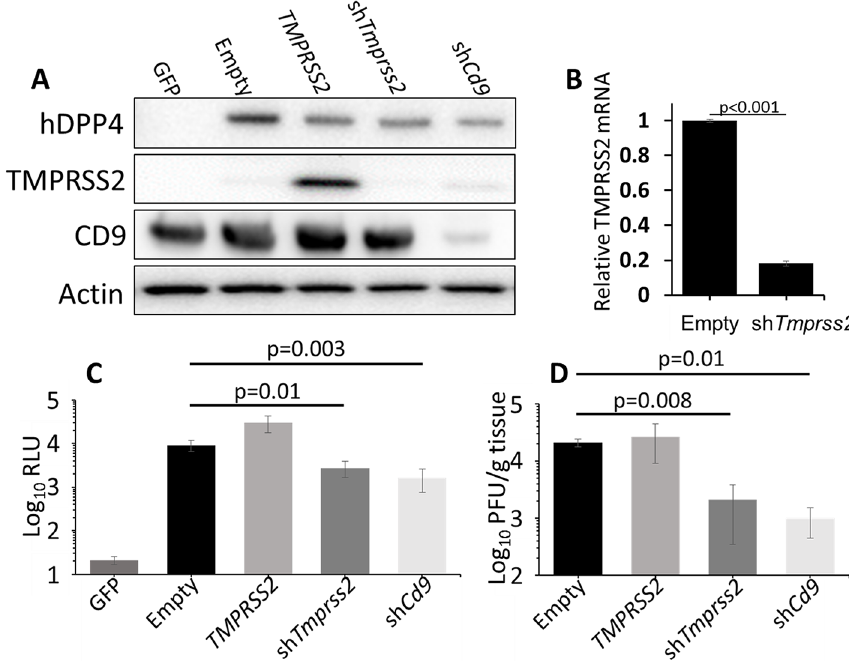
Fig 5. Analysis of Adenovirus knockdown of MERS entry factors. (A) LET-1 cells were transduced with an adenovirus carrying a GFP gene or adenoviruses carryinghDPP4 and either an empty vector, the TMPRSS2 gene, or a U6-drivenshRNA against TMPRSS2 or CD9. After 3 days, cells were lysed and analyzedby western blot for the indicatedproteins. (B) Quantitative rtPCR analysisof Tmprss2 transcripts in cells transduced with rAd5-hDPP4-EV and rAd5-hDPP4-sh Tmprss2 . (C) LET-1 cells were transduced with the indicatedAd5 vector before transducing with VSV-MERSpp. Transduction was measuredby luciferase assay. (D) The indicatedAd5-DPP4vectors were installedintranasallyin C57/Bl6 mice. 5 days later, mice were infected with MERS-CoV. Lungs were isolated at 2 dpi and viral titers were measuredby plaqueassay.